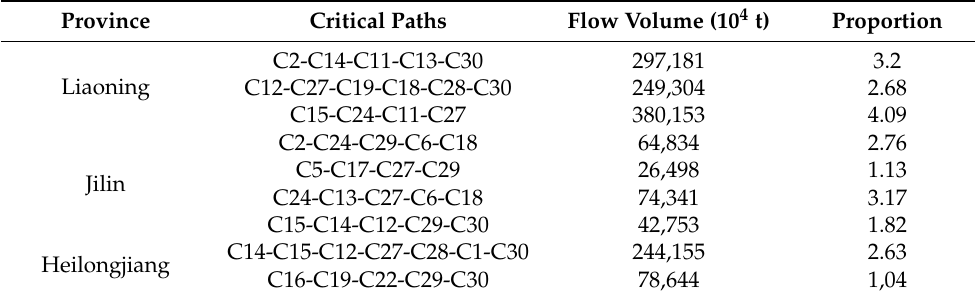
Table 10. Key Embodied carbon emission pathways in